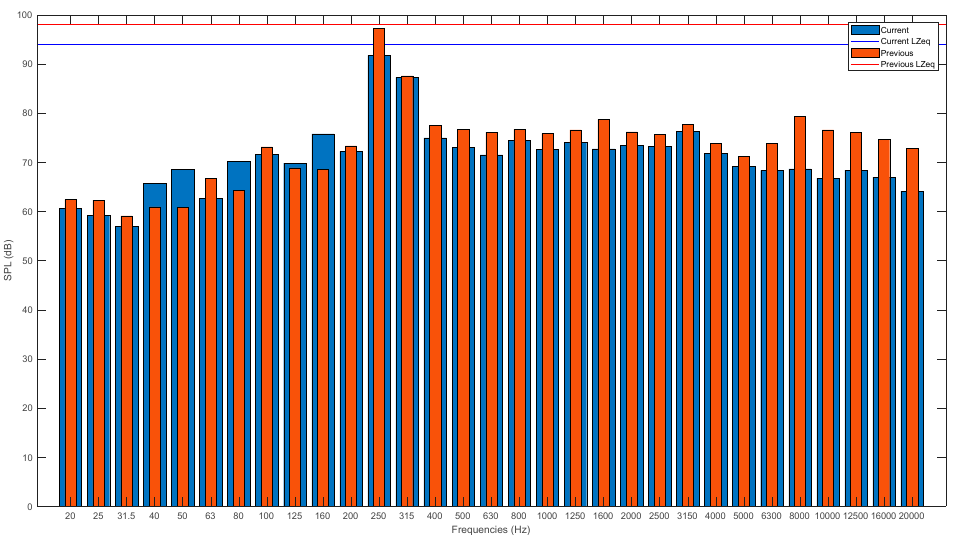
Figure 11. Results of the sound reduction redesign showing a bar plot of 1/3 octave noise measurements.